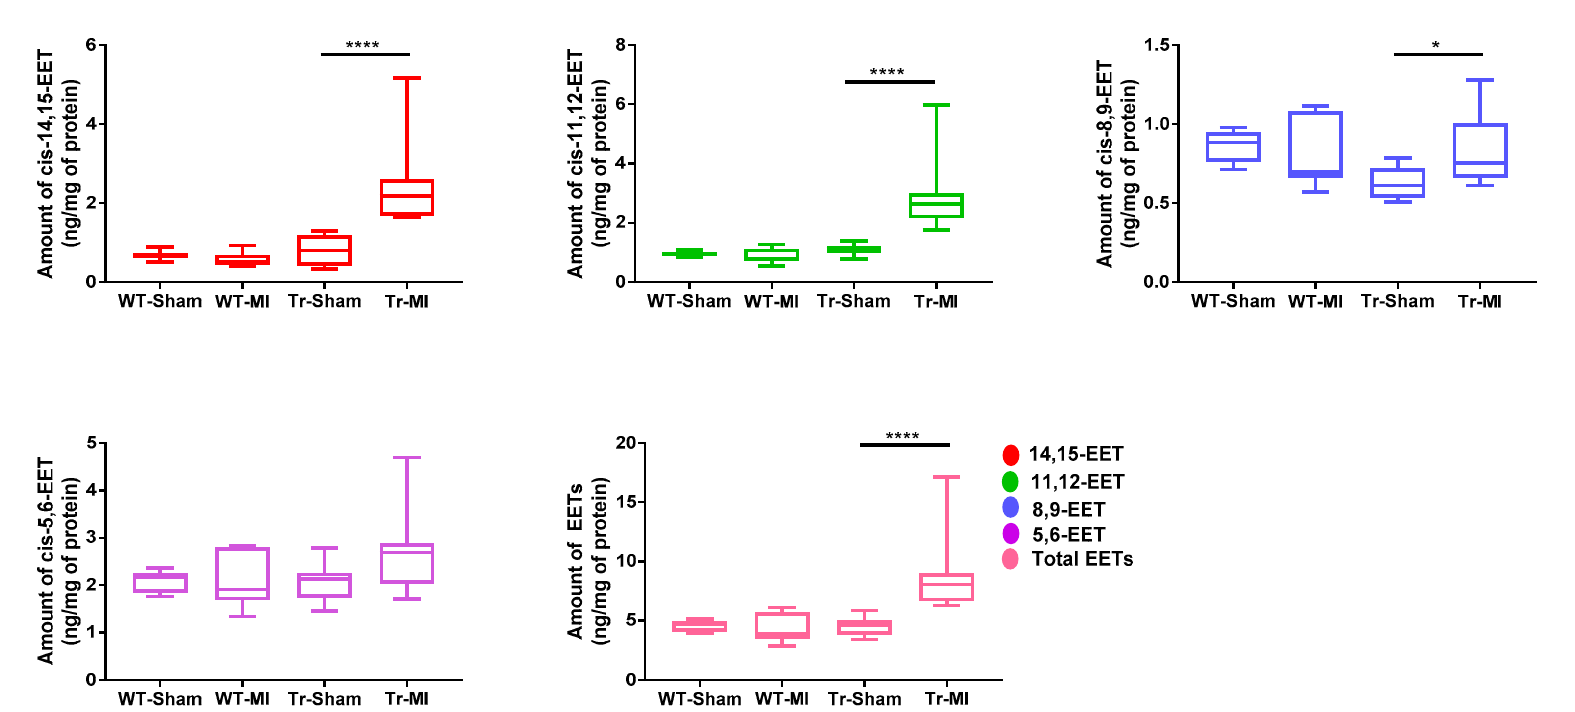
Figure 4. Levels of cis- epoxyeicosatrienoic acid (EET) regioisomers and total cis- EETs extracted from erythrocyte membrane of wild-type (WT) and transgenic (Tr) mice subjected to sham or myocardial infarction (MI) surgery. Eight WT mice (4 female (F) and 4male (M) mice) and nine Tr mice (4 F and 4 M were subjected to sham surgery, and 9 WT mice (4 F and 5 M mice) and nine Tr mice (4 F and 5 M mice) were subjected to MI surgery. * indicates p ≤ 0.05 and **** indicates p ≤ 0.0001